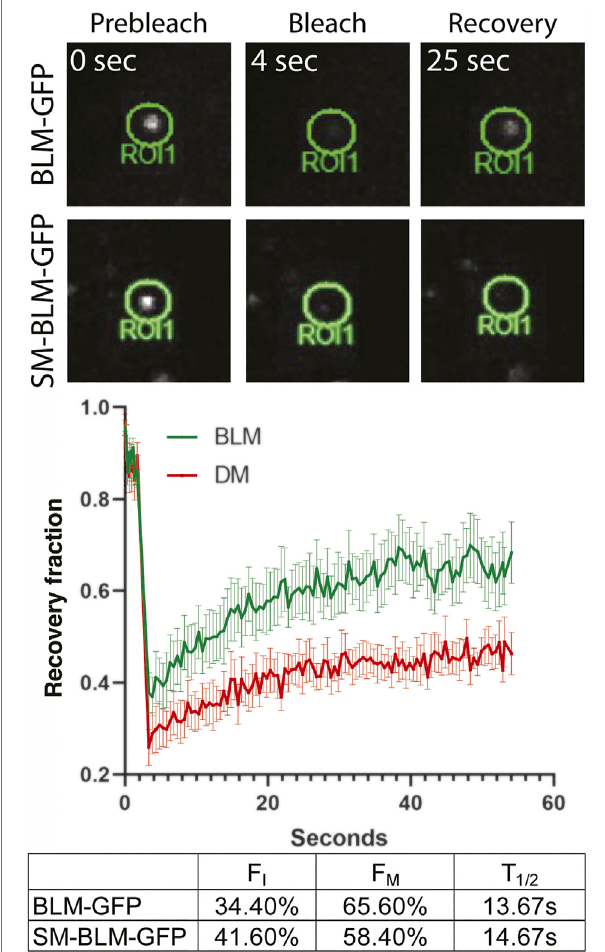
FIGURE 3 | Mobility of SUMO-mutant BLM at stalled forks is reduced. BLM + or SM-BLM cells were treated for 24 h with 2 mM HU. Single-foci regions of interest (ROIs, i.e., focal accumulations of GFP-BLM protein) were photobleached and signal recovery was followed for 1 min after bleaching at 0.5 s intervals. Examples of bleached ROIs are shown (top), and recovery fraction over time was plotted (bottom). Error bars represent SEM from three independent experiments. Time to half of maximum recovery is shown as T 1/2 . F I and F M represent immobile and mobile fractions,